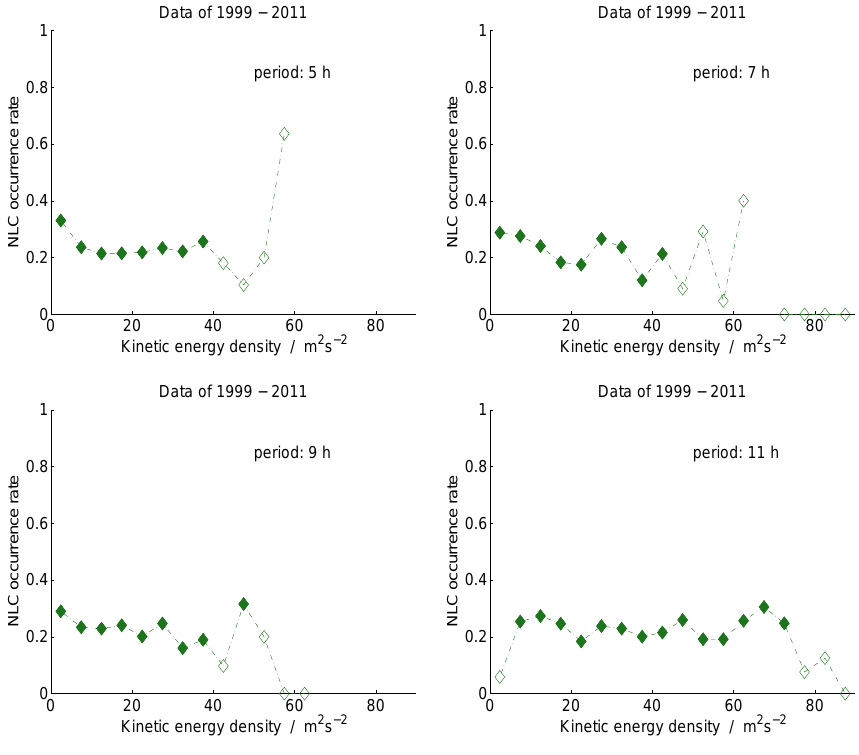
Fig. 3. The same as Fig. 2d, but for the 5h, 7h, 9h and 11h